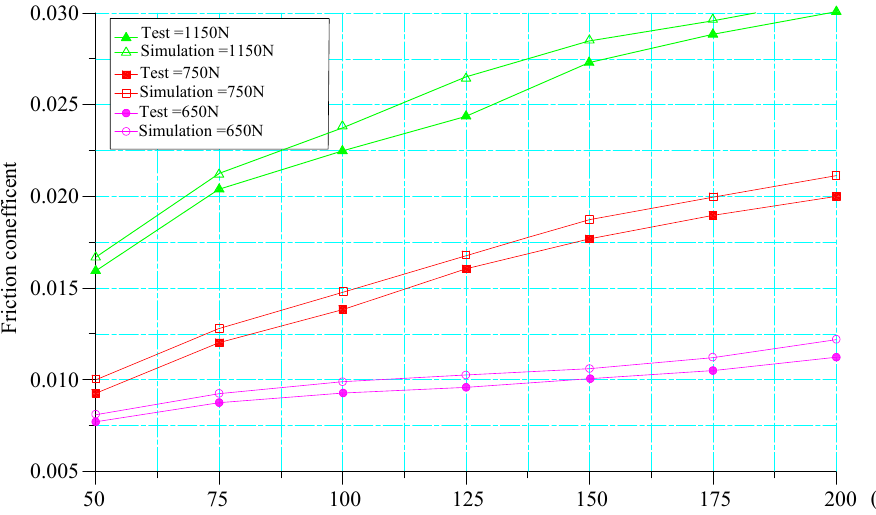
Figure 21. Comparison between friction coefficient and simulation results under test conditions of axial bearing with flow direction